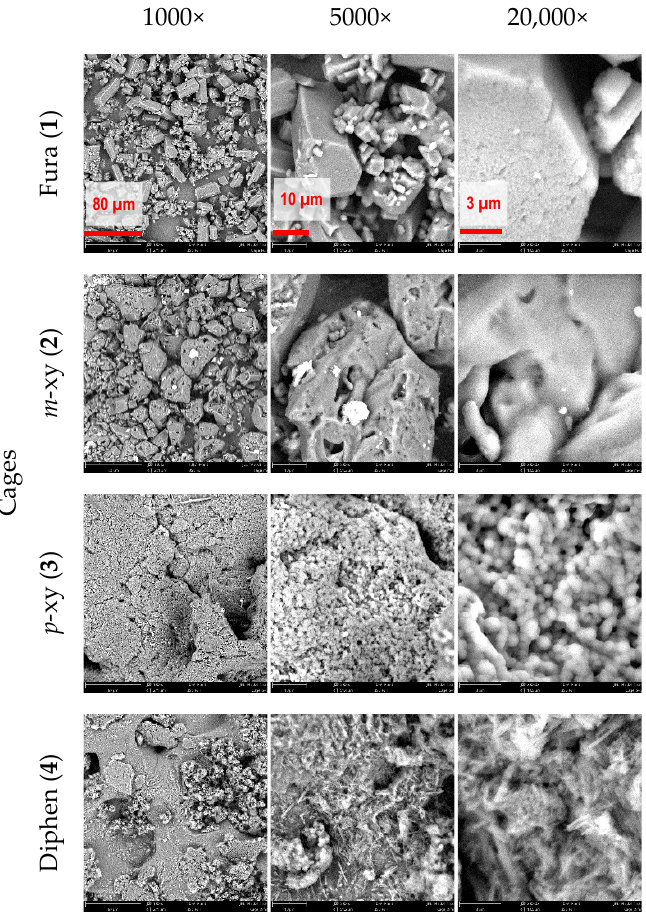
Figure 4. SEM images of Cages 1 – 4 as collected in their powder form at different magnifications.